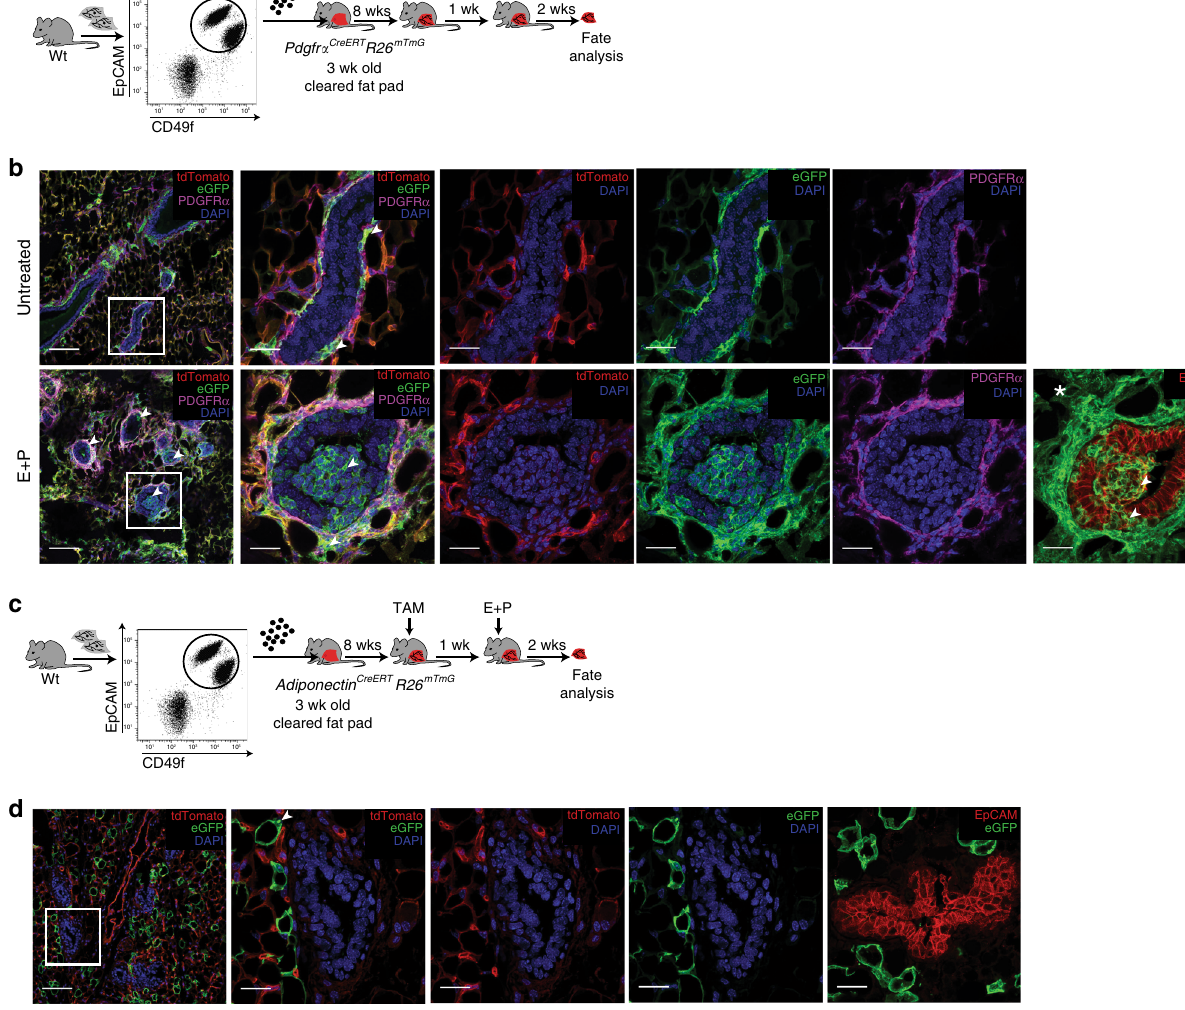
Fig. 6 Stromal to epithelial transition of mesenchymal cells in a tracing-in-transplant assay. a Stromal cell contribution to epithelia was tested by a lineage tracing-in-transplant strategy utilizing FACS-sorted wild type non- fl uorescent epithelial cells which were injected into inguinal cleared fat pads of Pdgfr α CreERT R26mTmG tracing mice that were later TAM induced and left untreated ( n = 6 fat pads) or treated with E + P hormones ( n = 6 fat pads). b Images of outgrowths representative of all transplanted fat pads (white boxed area on leftmost images shown at higher magni fi cation on right panels) with tdTomato (red), GFP (green), PDGFR α (magenta), DAPI (blue) and EpCAM (red). c Sorted wild type epithelial cell injections into cleared fat pads of AdiponectinCreERT R26mTmG mature adipocyte lineage tracing mice, also exposed to sex hormones following TAM induction. d Representative outgrowths ( n = 5) resulting from transplants in ( c ). Scale bar = 100 µ m (left; low magni fi cation) and 25 µ m (close-ups).; arrowheads indicate GFP + cells. White asterisk denotes associated Supplementary Movie